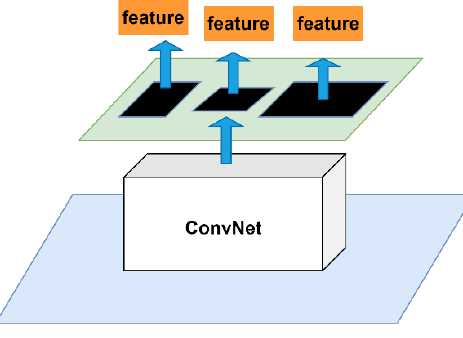
Figure 4. Structure of the SPP module.